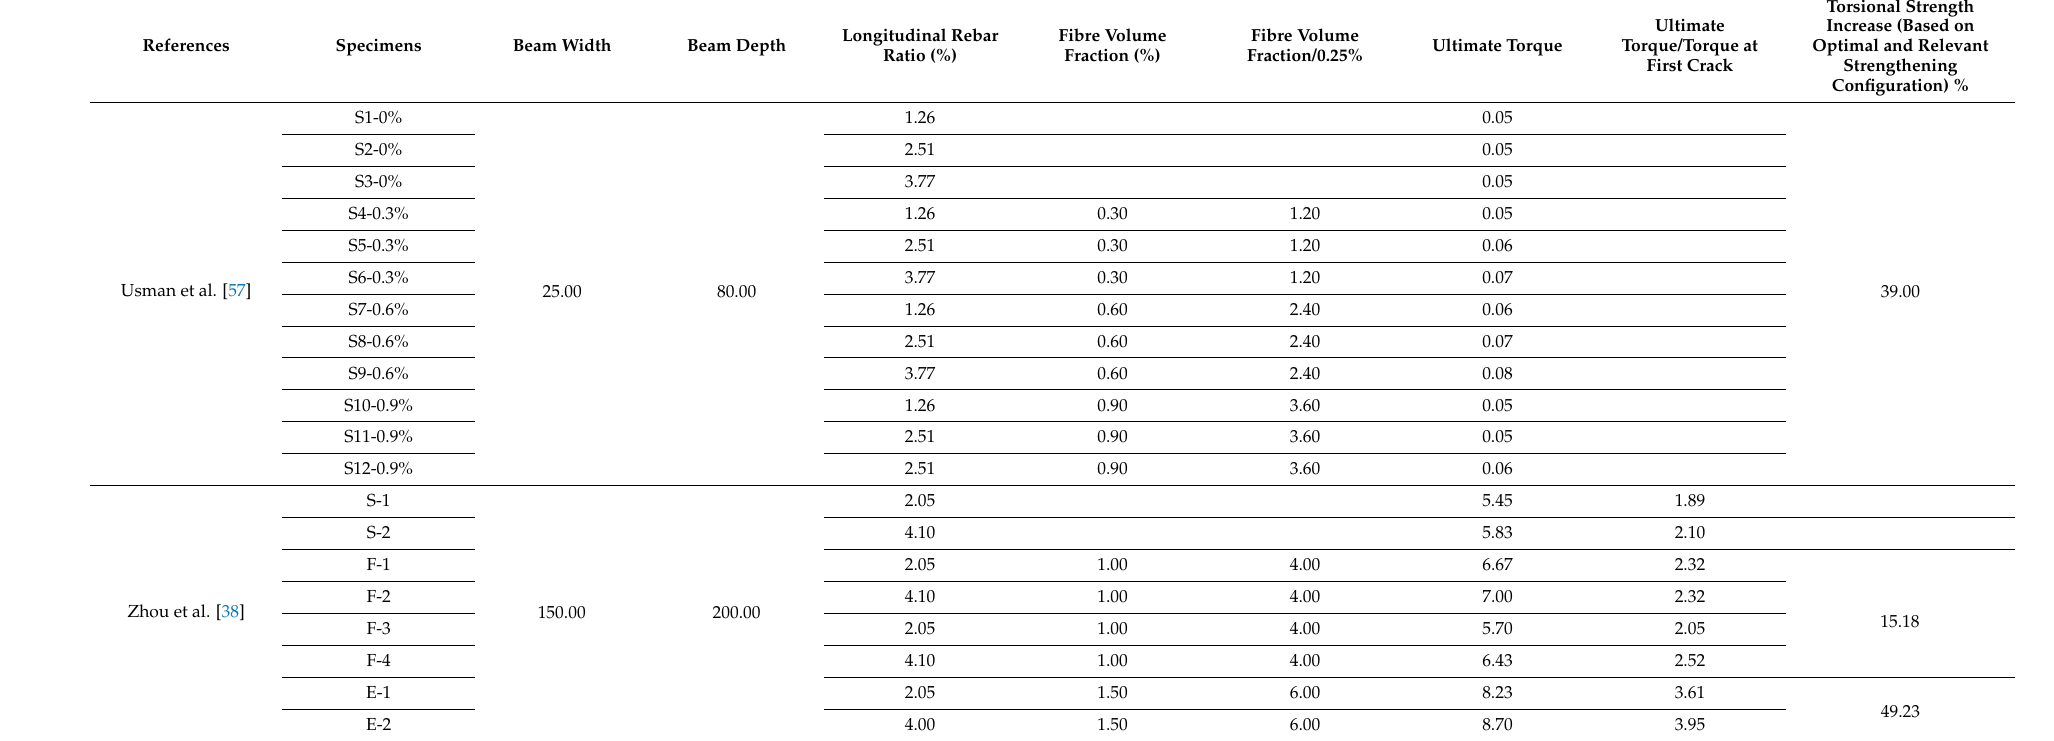
Table 8. Comparison of different experimental studies for synthetic fibre reinforced